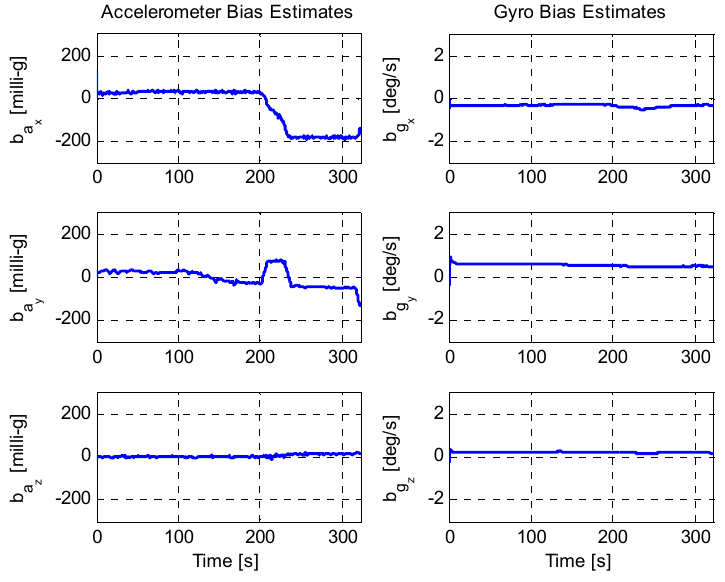
Figure 11. Accelerometer and gyroscope estimation based on the camera/IMU/GNSS integration.